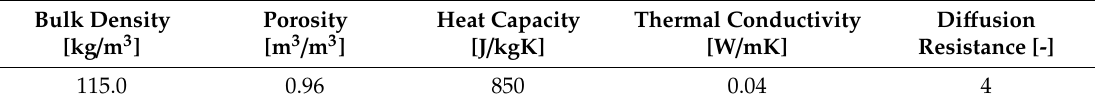
Table 1. Physical parameters of the insulation material (material manufacturer’s data).